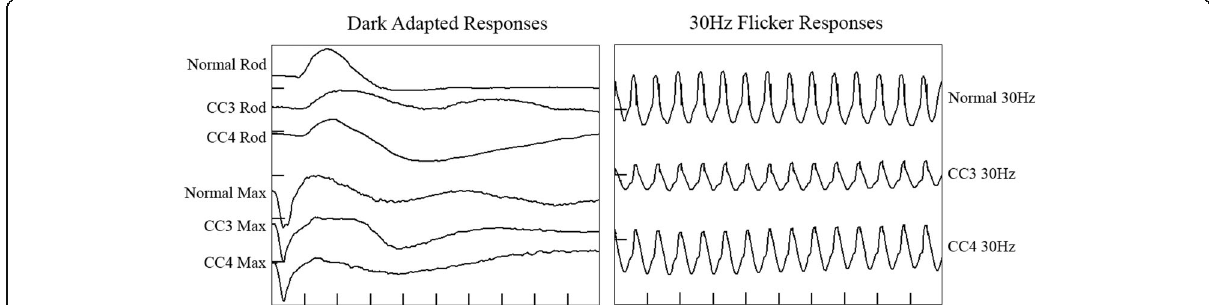
Fig. 3 ISCEV full-field electroretinogram [45] responses from affected grandsons (CC3 and CC4). Horizontal axis: 50 msec per division; Vertical axis: Dark Adapted Responses 500 μ V per division; 30 Hz Flicker Responses 250 μ V per division. The rod-isolated responses of CC3 and CC4 were slightly, but significantly reduced in amplitudes. The mixed rod and cone responses to the maximal intensity flash stimulus presented to the dark-adapted eye showed a normal a-wave amplitude in each subject, (CC3 445 μ V, CC4 441 μ V). The b-wave amplitudes were significantly reduced in each patient (CC3 515 μ V, CC4 502 μ V) and approximated the a-wave amplitudes. Ordinarily, the b-wave amplitude greatly exceeds that of the a-wave. The normal a-wave and selective reduction of the b-wave indicates preserved photo-transduction but impaired post-receptoral retinal function. This has been reported in RS1-associated X-linked retinoschisis